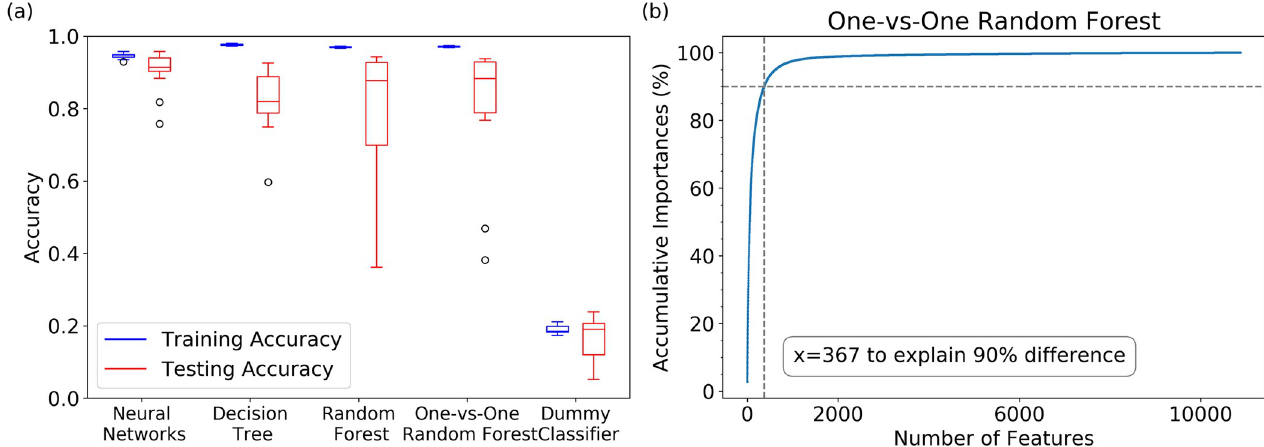
Fig 7. Four machine learning models (artificial neural networks, decision tree, random forest and one-vs-one random forest models) for VVD macrostates: (a) Model accuracy and a dummy classifier as control; (b) One-vs-one random forest classifier accumulating feature importance. One-vs-one random forest is the most effective model with 367 features out of 10,878 features accounting for 90% distinguishability.